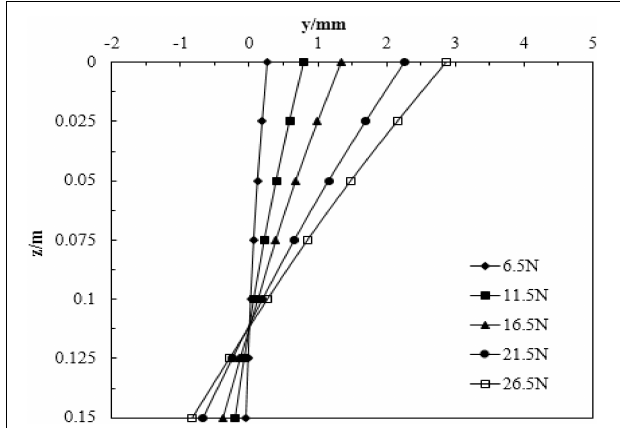
FIGURE 7 | Variation of the pile displacement under lateral load.